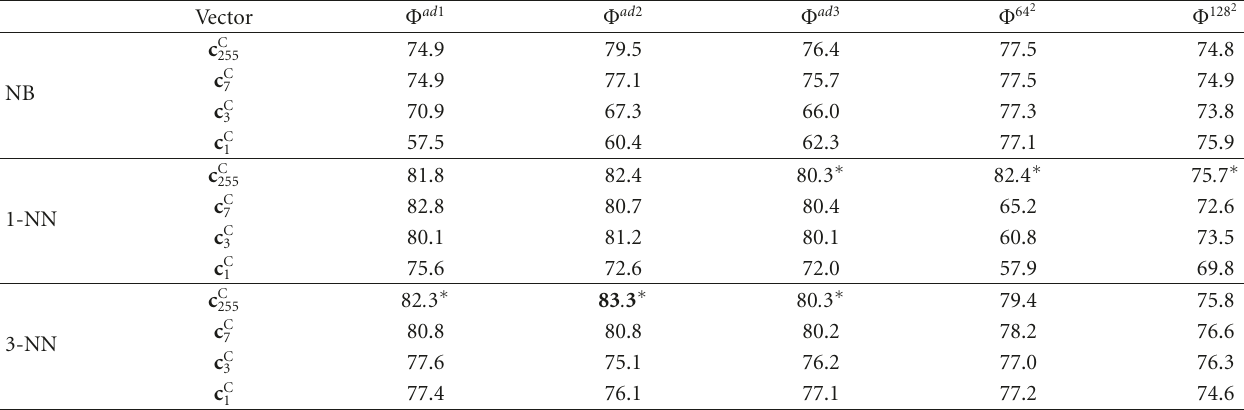
Table 4: Rate C P of correctly classified patterns for five image sets with Chen’s textural features. The best rate C P for each image set is shown by an ∗